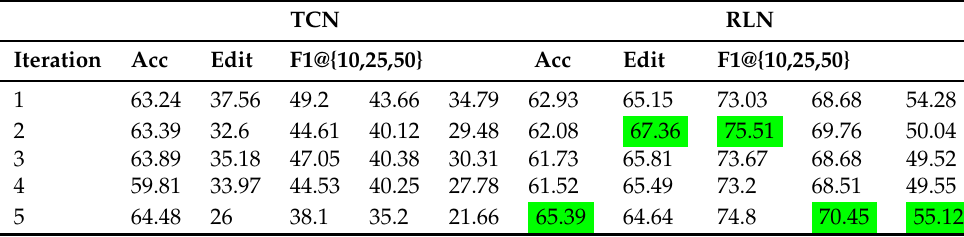
Table 7. RL-SSI in the Milk context.